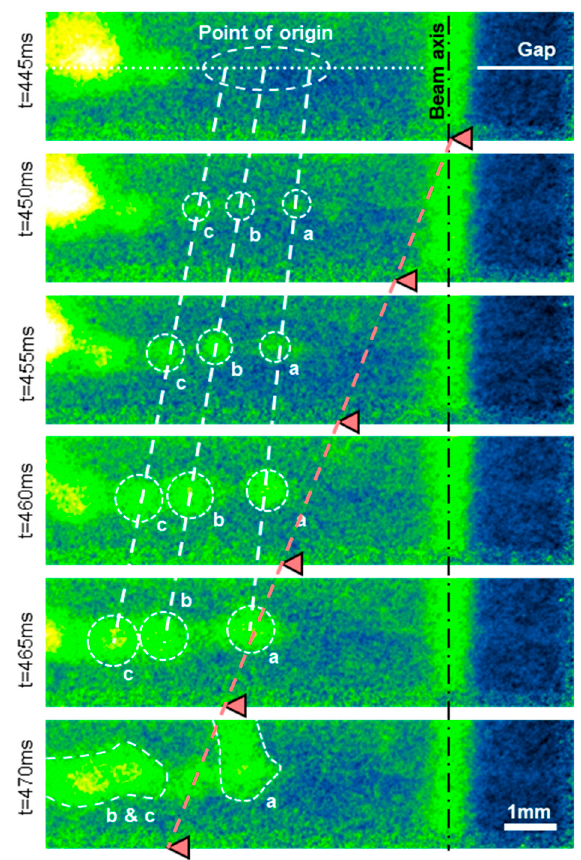
Figure 3. Determination of the point of origin of the pores by extrapolation across single frames of an X-ray video showing the formation of pores. Two uncleaned AA6016 sheets were welded in overlap configuration with a feed rate of 12 m/min, a beam diameter of 500 µm, and a laser power of 8.5 kW. The comparison between the inclination of the white dashed lines and the inclination of the red dashed line showed that the velocity of the movement of the bubbles in x-direction was lower than the welding feed rate. No significant movement in the z-direction was observed. The bubbles appeared at t = 450 ms in the weld pool a few millimeters behind the capillary (on the left-hand side of the capillary in Figure 3) at the gap level between the two sheets (the dotted line at t = 445 ms). From this, it can be concluded that the bubbles originate at the gap’s level (the dotted line at t = 445 ms) but form in the weld pool at the locations where the dashed white lines cross the dotted line, which is a few millimeters behind the capillary, as highlighted by the dashed ellipse.